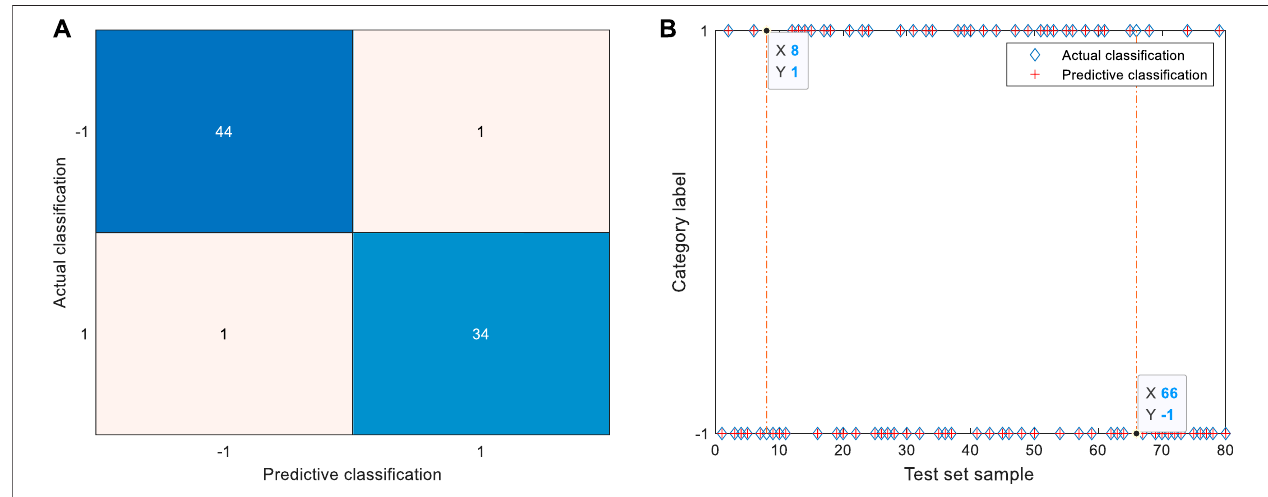
FIGURE 6 | Identi fi cation results of six physical signs by GSA-SVC. (A) Confusion matrix of test set. The TP is 44, TN is 34, FP is 1, and FN is 1; (B) Identi fi cation results of test set. The 66th samples were misclassi fi ed as abnormal coal miners in the test set. The eighth samples were misclassi fi ed as normal coal miners in the test set.